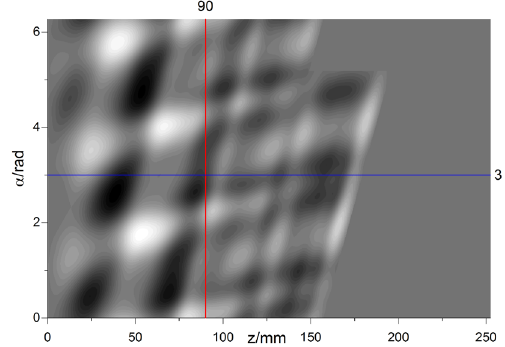
Fig. 4. Contour plot of wall perturbations of the designed hybrid-type quasi optical launcher for the upgraded gyrotron.